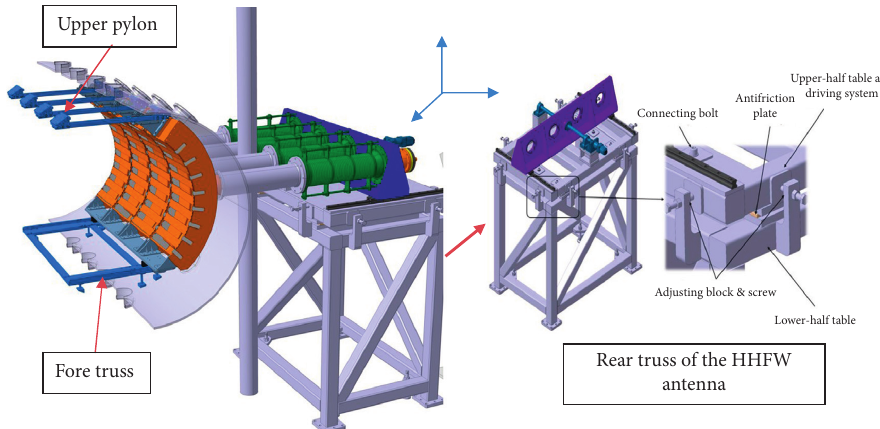
Figure 5: Structure of the HHFW antenna